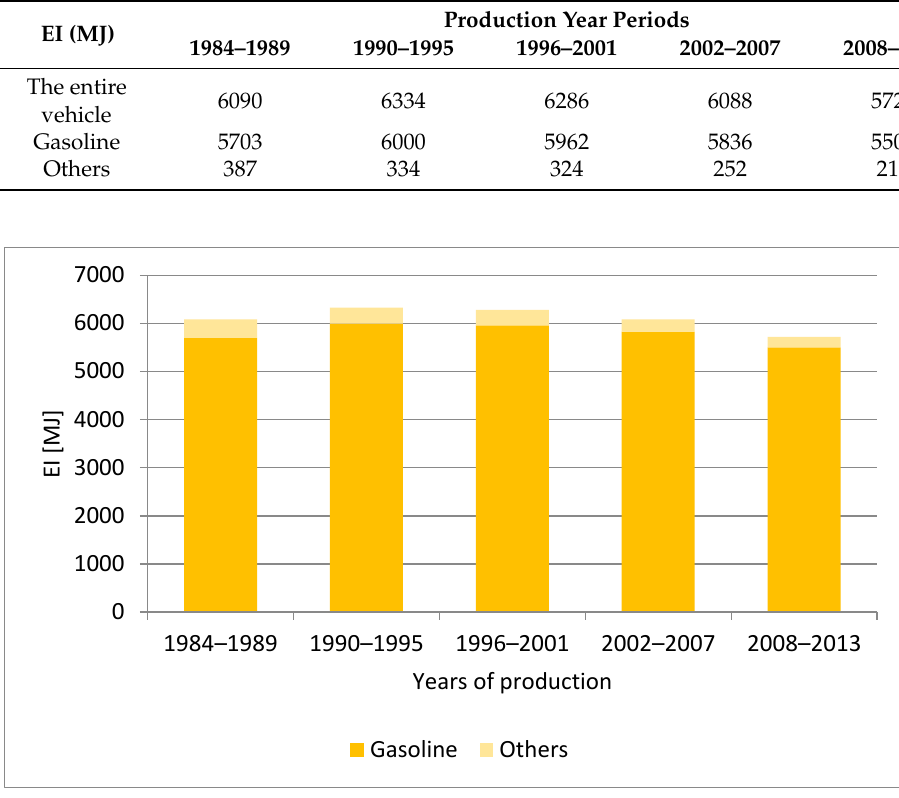
Figure 4. Energy input for the entire passenger car.